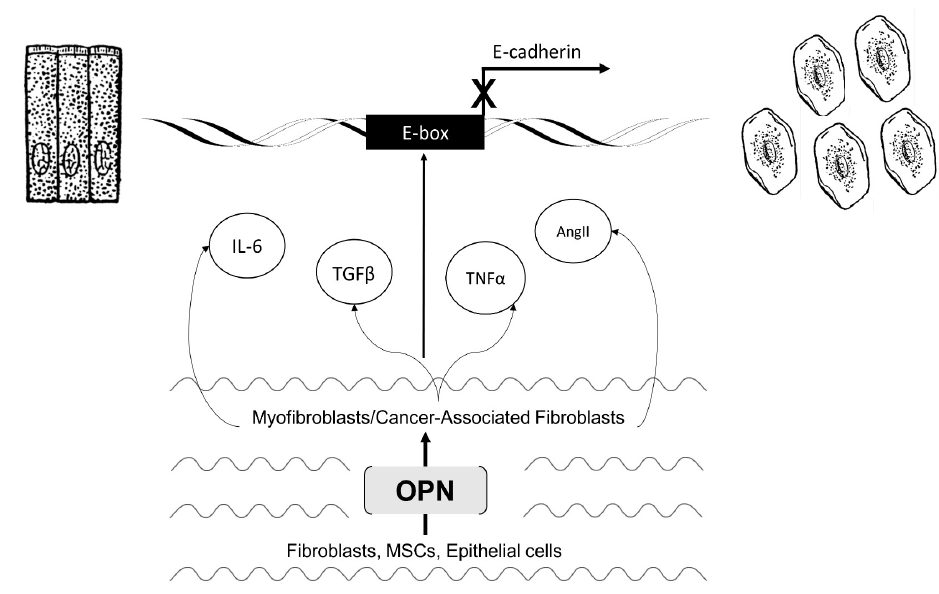
Figure 3. Microenvironmental regulation of EMT by OPN ‐ mediated activation of stromal elements. IL ‐ 6 is another key signaling molecule involved in EMT that can come directly from activated CAFs. In gastric cancer, IL ‐ 6 released by CAFs is able to modify the phenotype of tumor cells using IL ‐ 6/JAK/STAT3 signaling. Activation of this pathway results in tumor cell EMT and invasiveness,